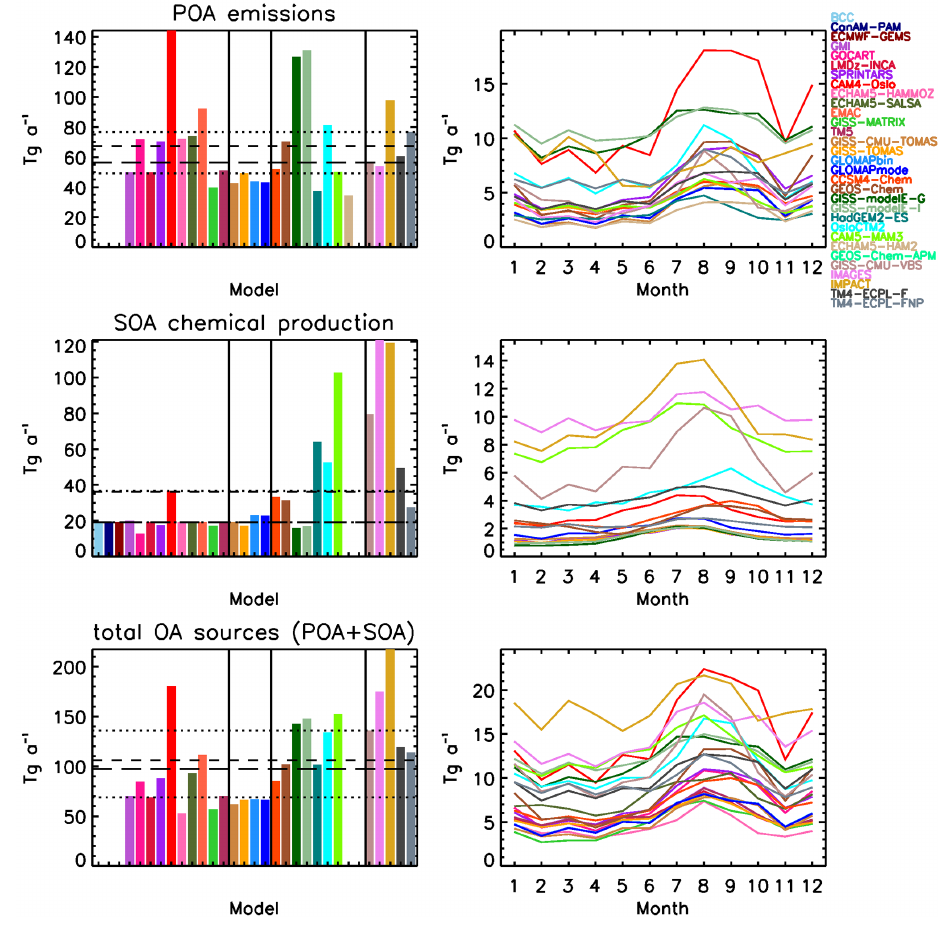
Figure 2. Top row: POA emissions included in models (before POA evaporation in the case of GISS-CMU-VBS); middle row: SOA chemical production (including the pseudo-primary SOA source, where applicable); bottom row: total OA sources (sum of top and middle rows) for the annual mean (left column; short dashes: mean; long dashes: median; dotted lines: 25/75% of the data) and seasonal variability (right column). Note that not all models have submitted annual budget data, and fewer have submitted seasonal information; thus, their corresponding columns/lines are not shown. The models are grouped based on their complexity, as separated by vertical solid lines in the annual mean budgets. Groups from left to right: SOA is directly emitted as a non-volatile tracer; SOA is chemically formed in the atmosphere, but is considered non-volatile; SOA is semi-volatile; SOA is semi-volatile and also has VBS (GISS-CMU-VBS) or multiphase chemistry